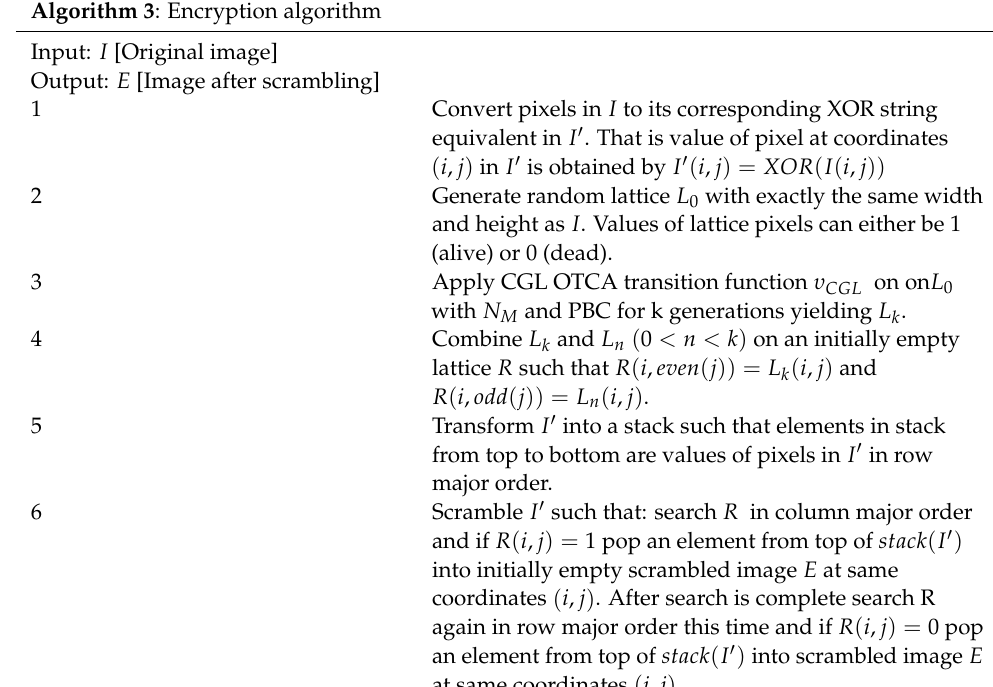
Algorithm 3 : Encryption